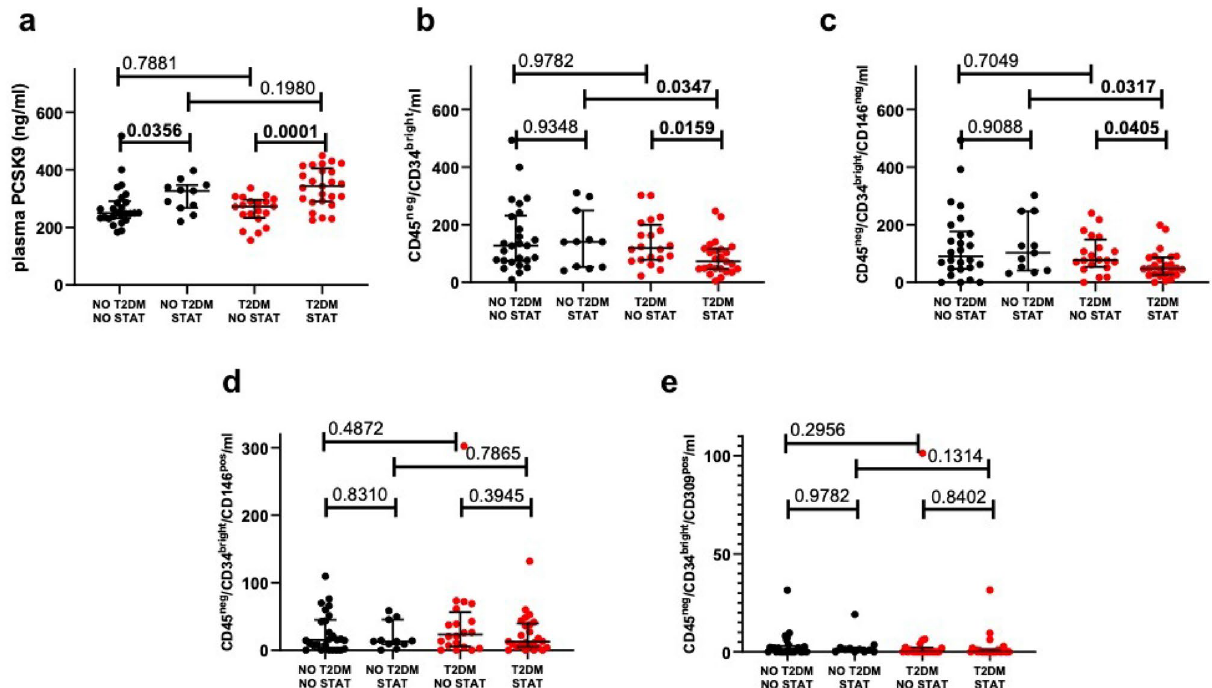
Figure 2. Effect of statin treatment . Levels of plasma PCSK9 ( a ) and number of CD45 neg /CD34 bright ( b ), CD45 neg /CD34 bright /CD146 neg ( c ), CD45 neg /CD34 bright /CD146 pos ( d ) and CD45 neg /CD34 bright /CD309 pos ( e ) in statin-treated patients (STAT) and in patients not on statins (NO STAT) with and without